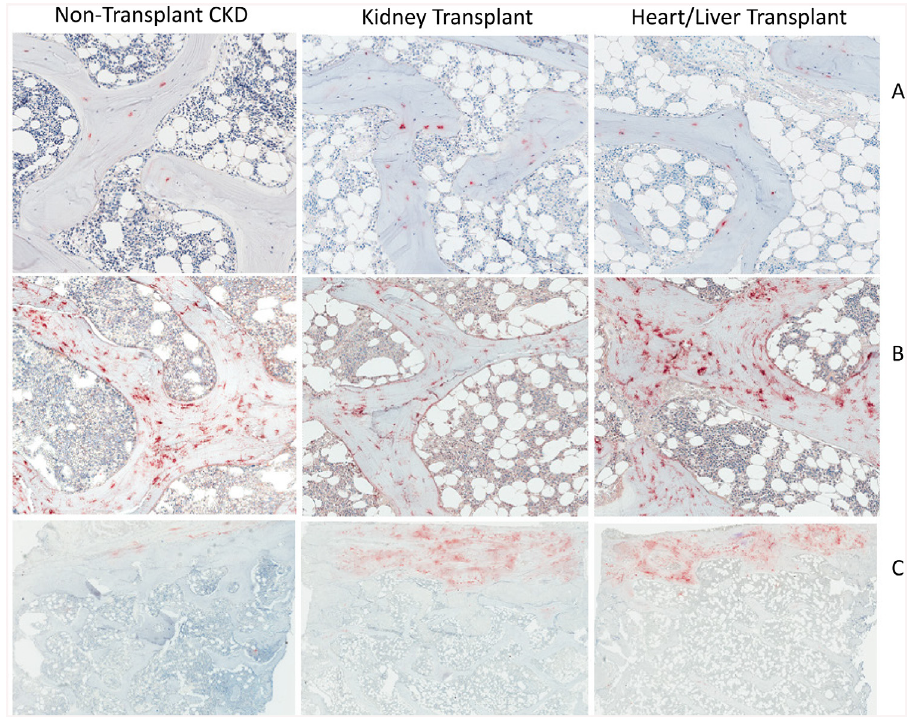
Fig 1. Bone (A) FGF23; (B) DMP1 and (C) sclerostin expression in representative samples from a non- transplant CKD patient, a kidney transplant recipient, and a heart transplant recipient.